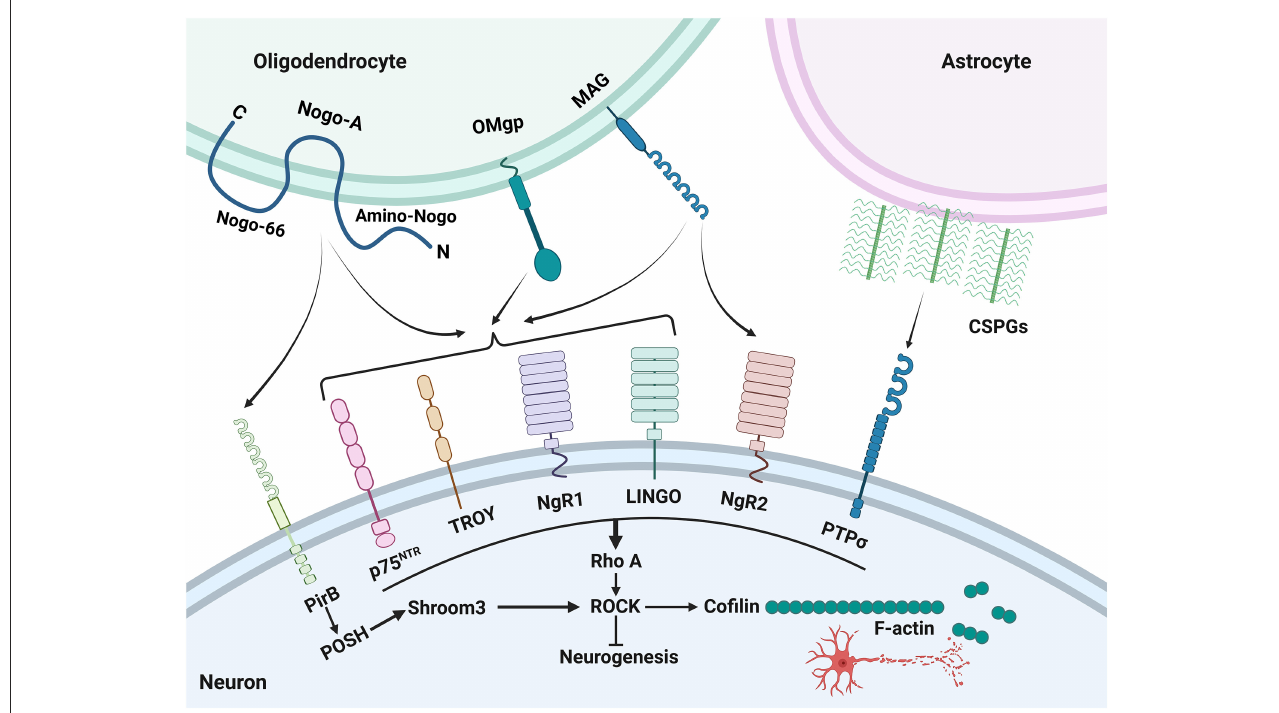
FIGURE2 Inhibiting factors of neurogenesis and their major downstream signaling pathways. After an ischemic stroke, various growth inhibitory molecules (Nogo-A, MAG, OMgp, and CSPG) from myelin and reactive astrocytes interact with various receptors, such as PirB, NgR1/2, LINGO, p75 NTR , PTP σ , and TROY, to signal through a convergent downstream pathway within the axon, leading to collapse of growth cones and inhibition of axonal